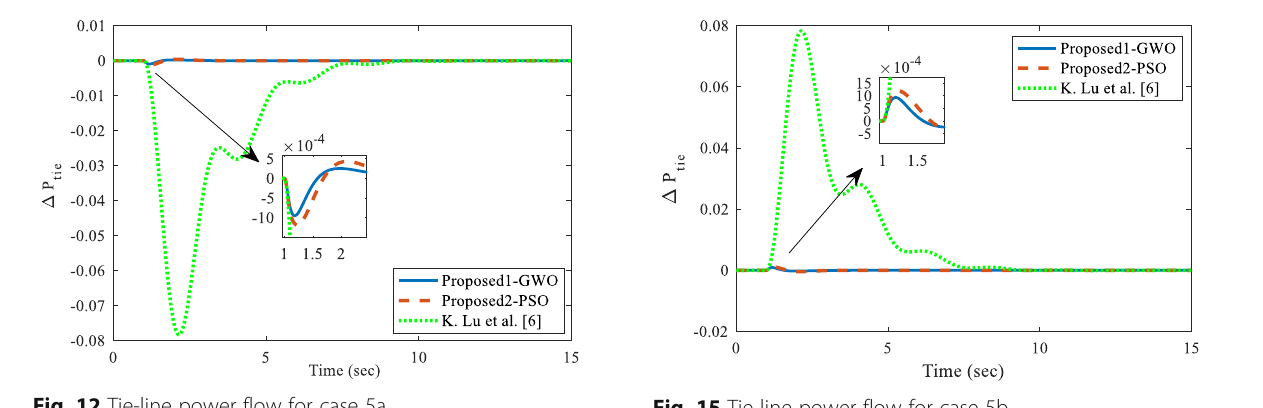
Fig. 12 Tie-line power flow for case 5a